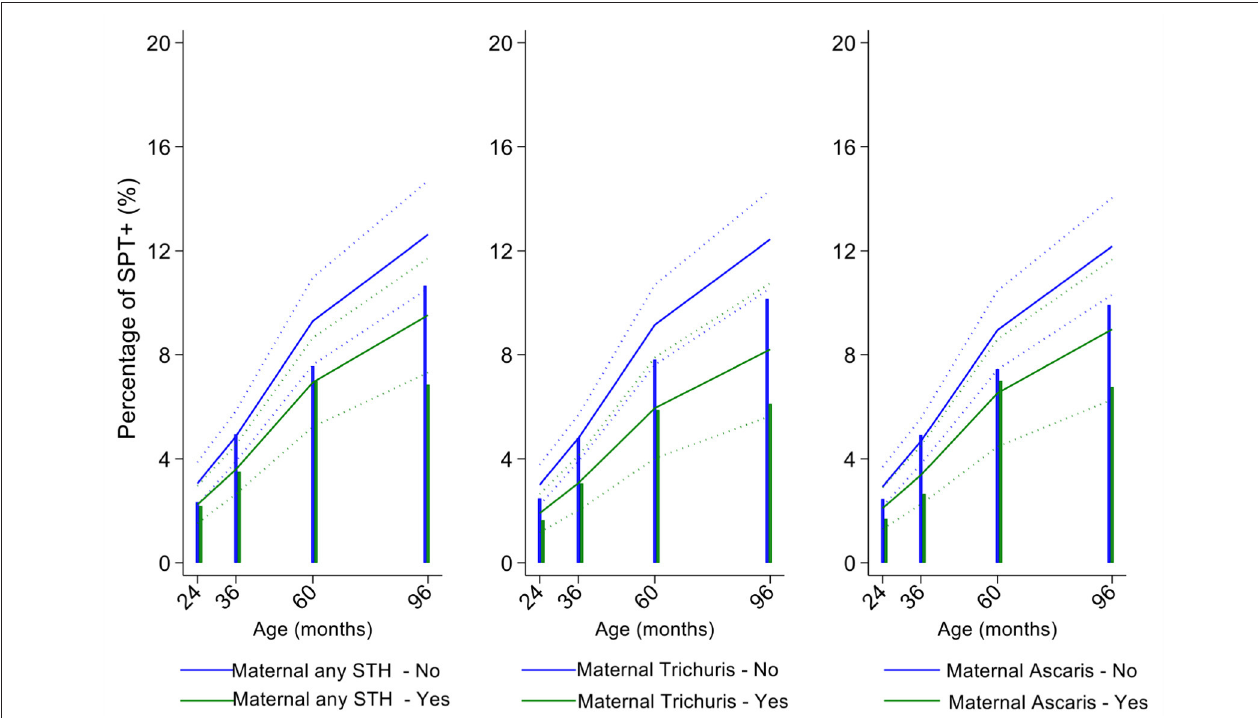
FIGURE 6 | Effect of maternal infections with any soil-transmitted helminth (STH) parasites or with specific STH species on age-dependent proportions of cohort children with allergen skin prick test positivity (SPT + ) to mite. Shown are predictions from population average longitudinal models (predictions shown by solid lines and 95% confidence intervals by dotted lines) against raw data percentages (bars). Blue lines/bars—children of uninfected mothers; green lines/bars—children of infected mothers.